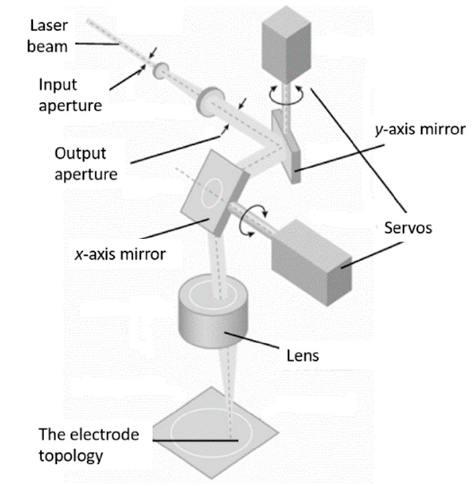
Figure 3. Structural scheme of the setup for local laser evaporation.